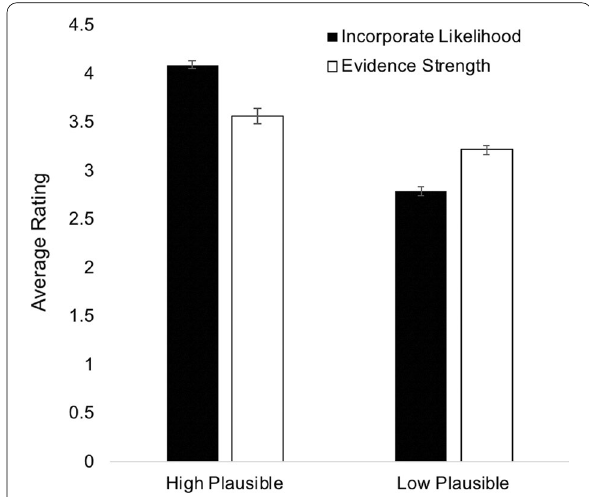
Fig. 5 Means of ratings for evidence strength and incorporate likelihood as a function of intervention plausibility for Experiment 2. Error bars represent within-subjects standard error of the mean (Cousineau, 2005)